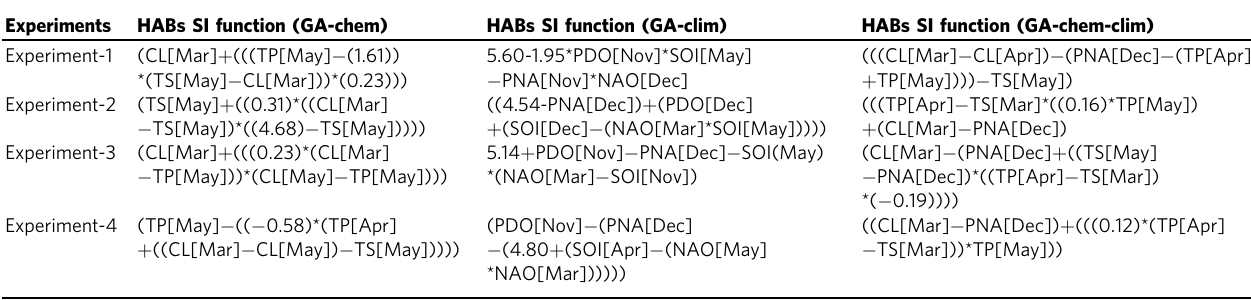
Table 4 HABs SI functions for GA-chem, GA-clim and GA-chem-clim for the 4 experiments.